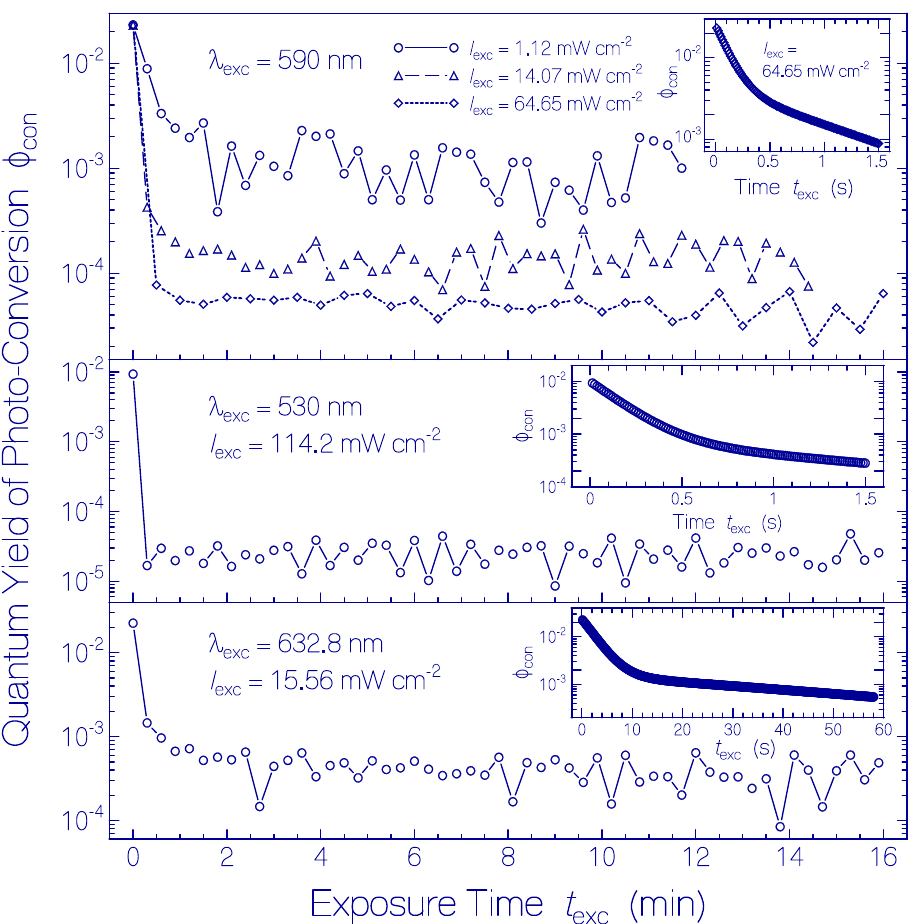
Figure 5. Quantum yield of photoconversion φ con of Ret_580 of QuasAr1 in pH 8 Tris bu ff er to other retinal isomers during light exposure. ( Top part ) Photoexcitation with LED 590 nm using listed input light intensities (values derived from Figures 1a, S1a and S4a). ( Middle part ) Photoexcitation with LED 530 nm using excitation intensity of I exc = 114.2 mW cm − 2 (values derived from Figure S6a). ( Bottom part ) Photoexcitation with He-Ne laser using I exc = 15.56 mW cm − 2 (values derived from Figure S10a). The curves in the insets are derived from the high time resolution absorption measurements (top part of Figure 4 for λ exc = 590 nm, top part of Figure S9 for λ exc = 530 nm, and top part of Figure S13 for λ exc = 632.8 nm).